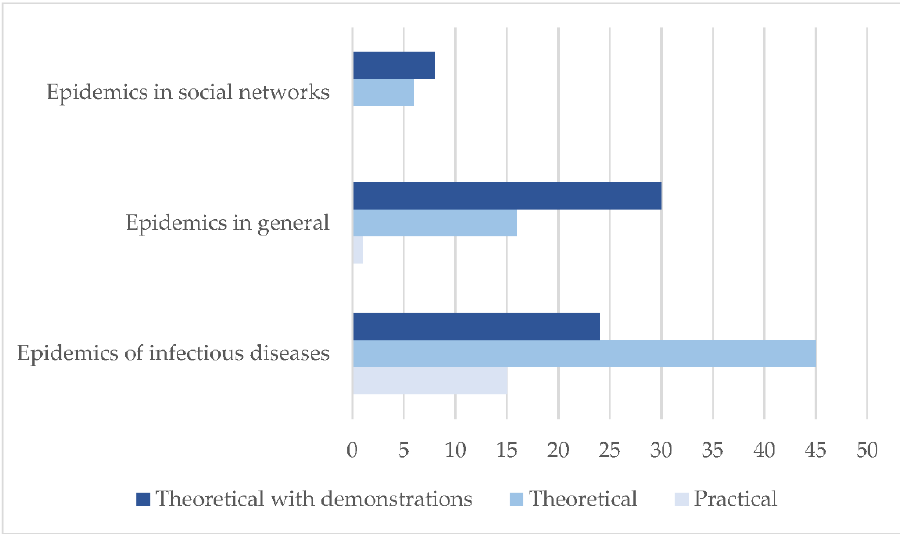
Figure 4. Articles by field and type of work.